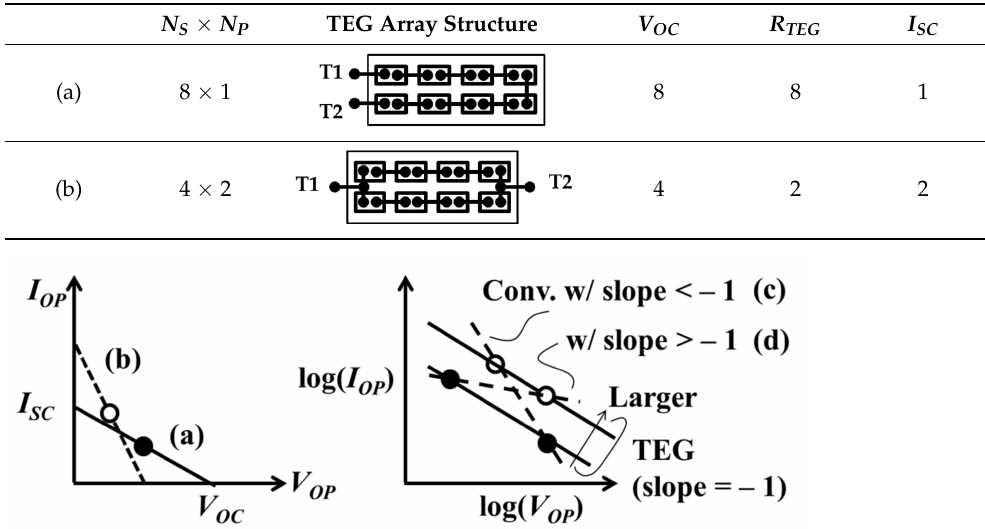
Table 1. Electrical parameters depending on TEG array structure.